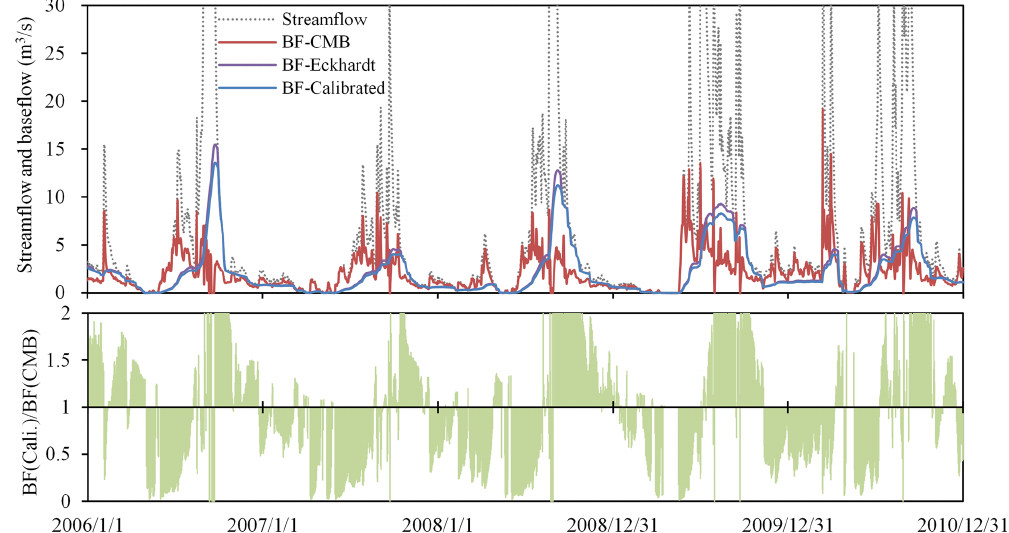
Figure 3. Bias between daily baseflow series generated by the conductivity mass balance (CMB) and Eckhardt methods after calibration for the United States Geological Survey (USGS) station 02298202. BF represents baseflow. The lines beyond the coordinate range are not shown to show the details more